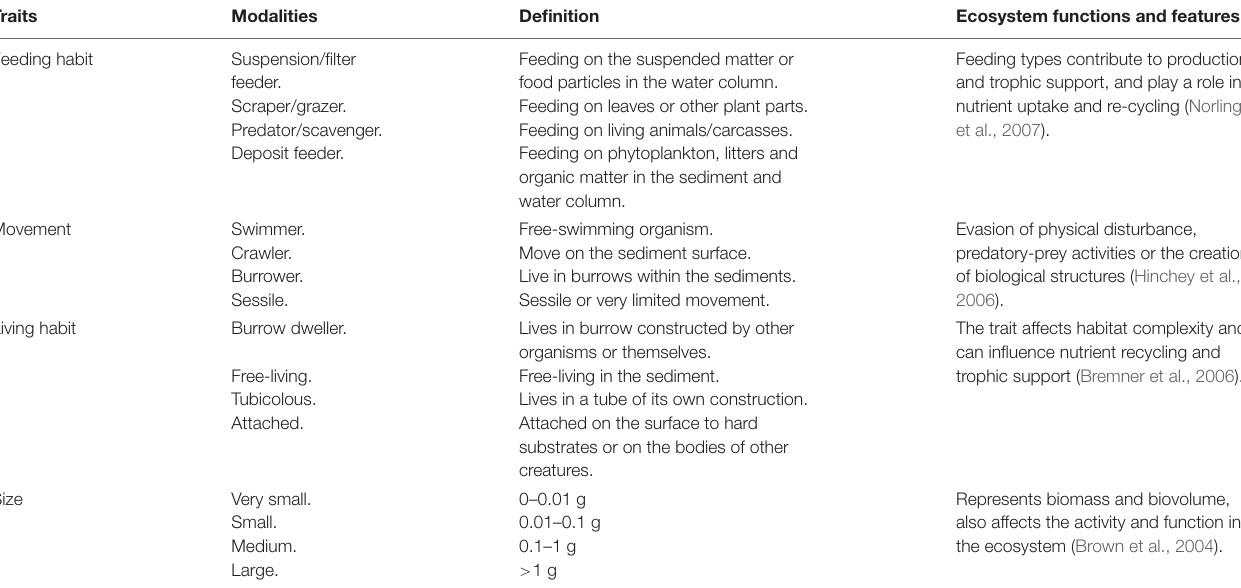
TABLE 1 | The traits and functional modalities included in the study, and the possible links to ecosystem functions and features. Traits Modalities Definition Ecosystem functions and features Feeding habit Suspension/filter feeder.